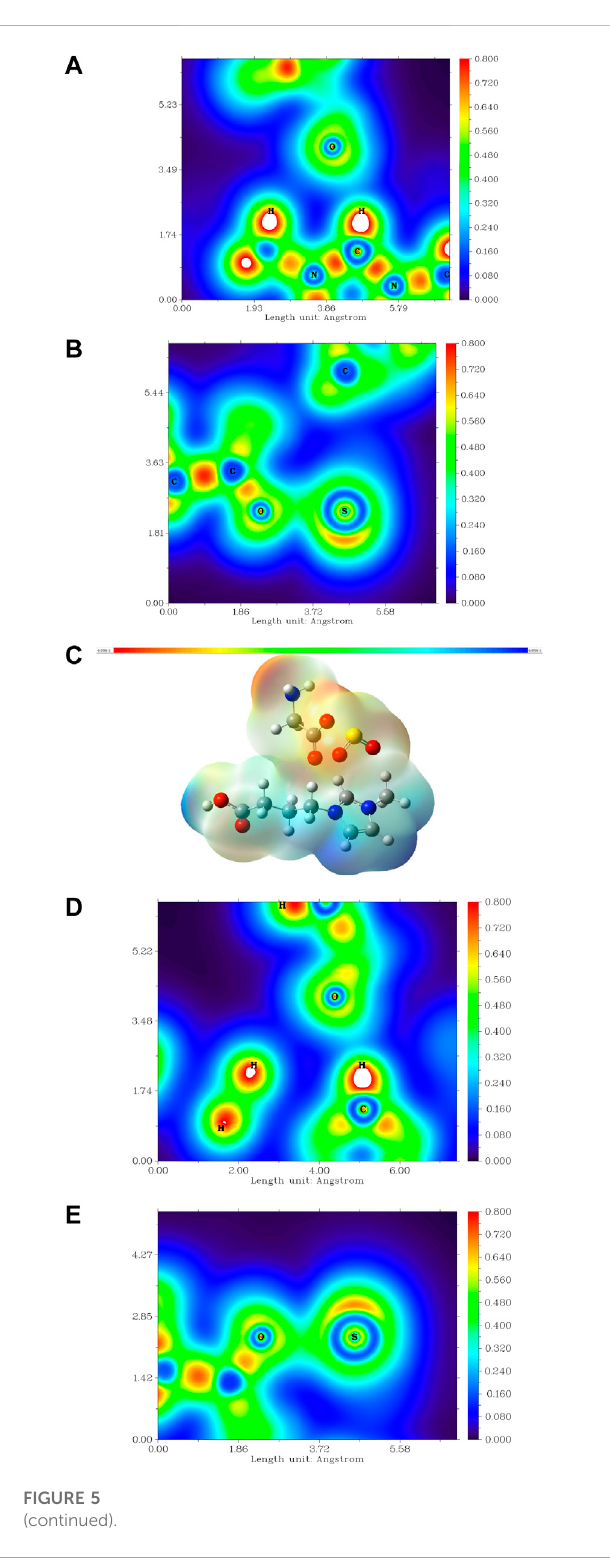
interaction between the absorbent and the SO 2 gas molecule. In the case of amine, ether, and hydroxyl functional groups, the BE values are to some extent equal and the S atom of SO 2 has also equal NCTA. AAIL with the carboxylic acid functional group is the most stable structure; it may be that SO 2 breaks the HB between anion and cation